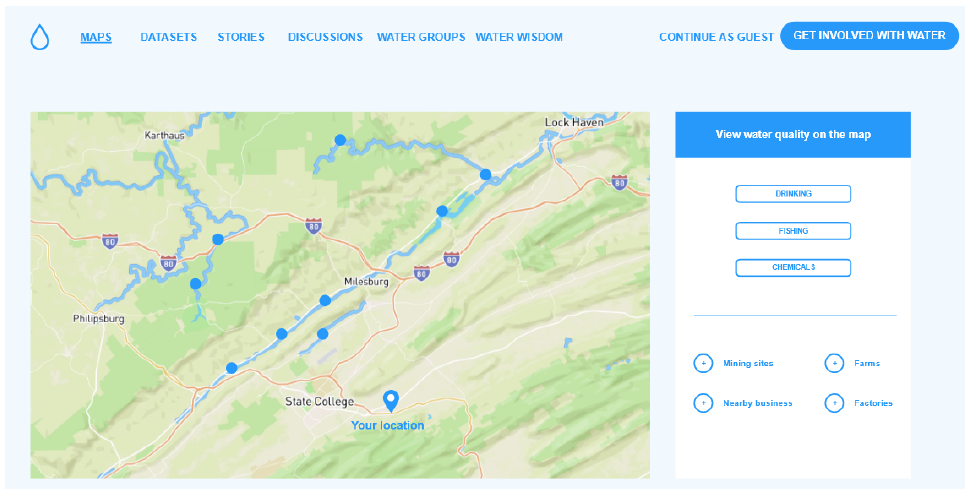
Figure 2. Screenshot of home screen of water data platform